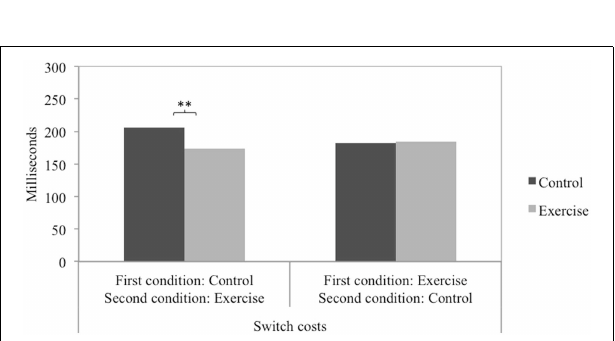
TABLE 4 | Regression of exercise induced switch trial gain ( N = 131), b = unstandardized regression coefficient, SE = standard error, b * = standardized regression